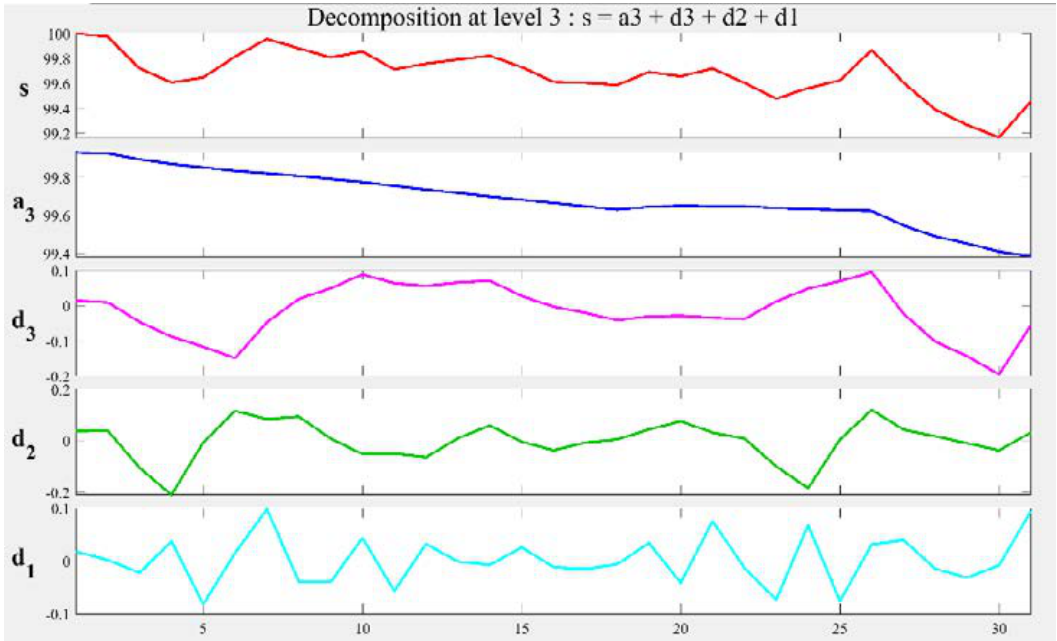
Fig. 10: Decomposition of NO x time series with ‘sym2’ wavelet at level 3